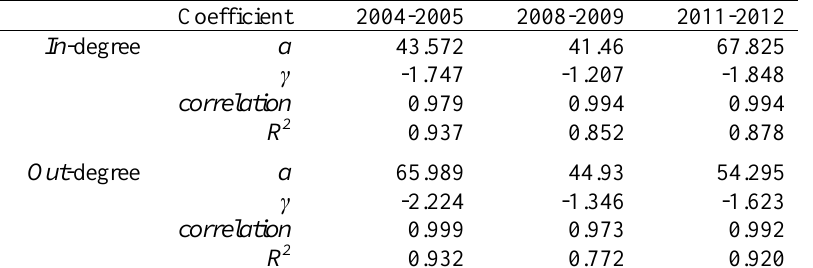
Table A1.2. Power law values for CT lease trade degree